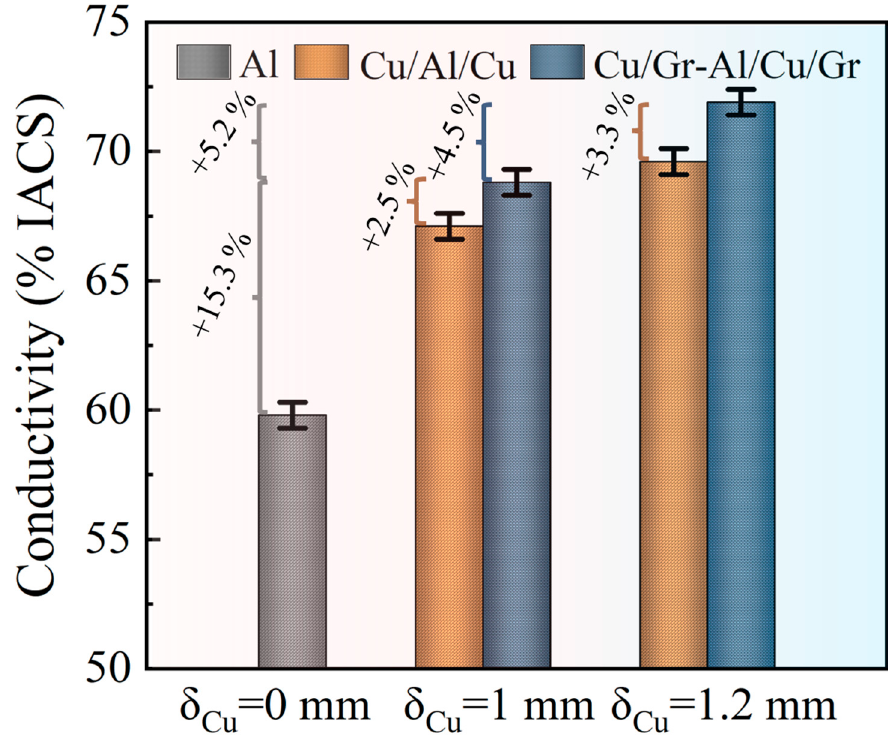
Figure 9. Comparison of the electrical conductivity of three different Cu(111) and Cu(111)/Gr thickness (0 mm, 1 mm and 1.2 mm) in the composites.